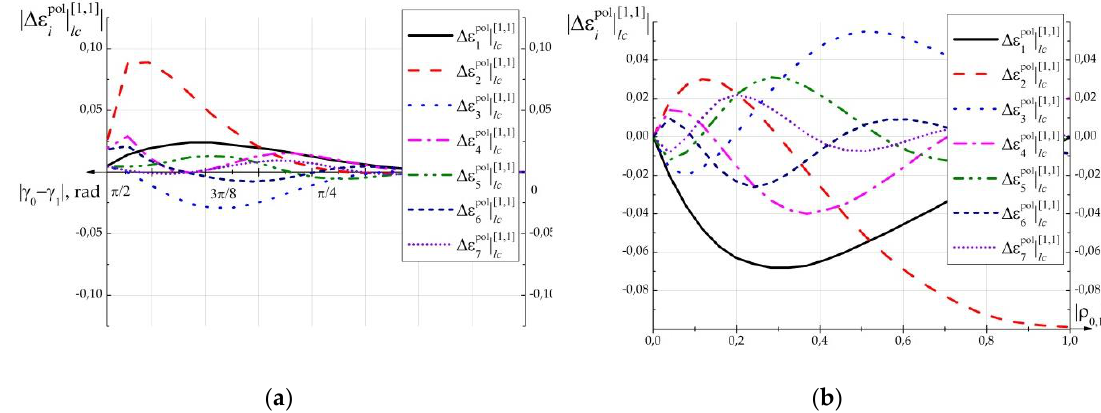
Figure 5. Amplitudes of harmonics of dielectric permittivity perturbation for polarization grating formed in PSLC: ( a ) As a function of an angle between polarization vectors of two orthogonally linearly polarized formation beams; ( b ) as a function of the ellipticity of the two formation beams with orthogonal elliptical polarization ρ 0 = − ρ 1